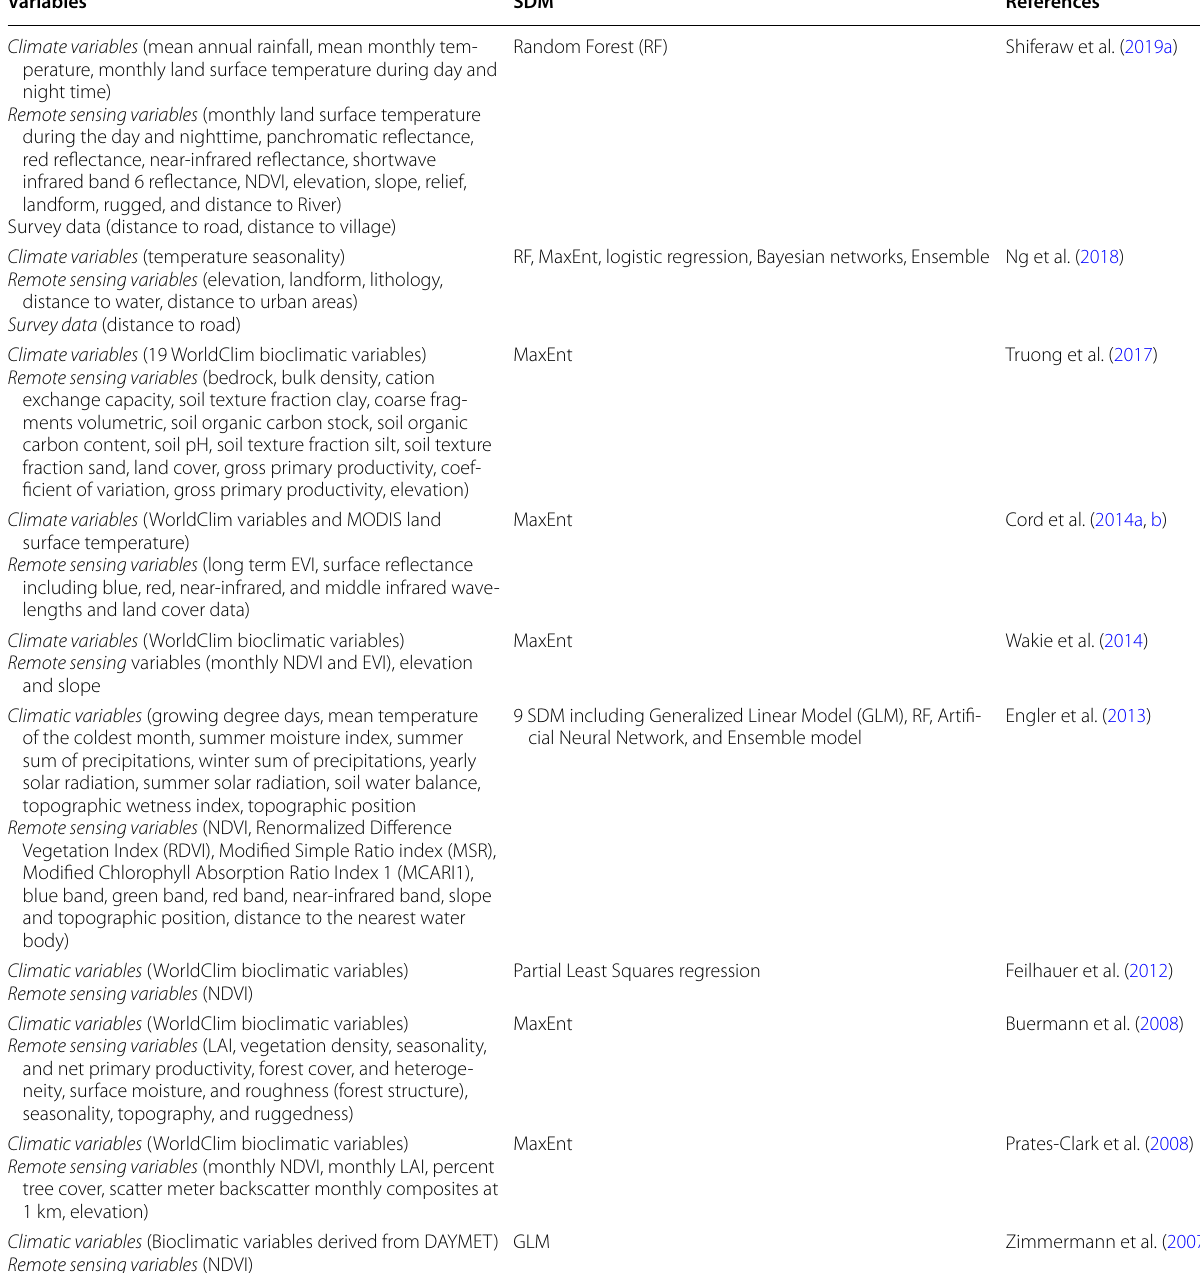
Table 1 Variables, SDM, and species used in combination of both datasets of some researches Variables